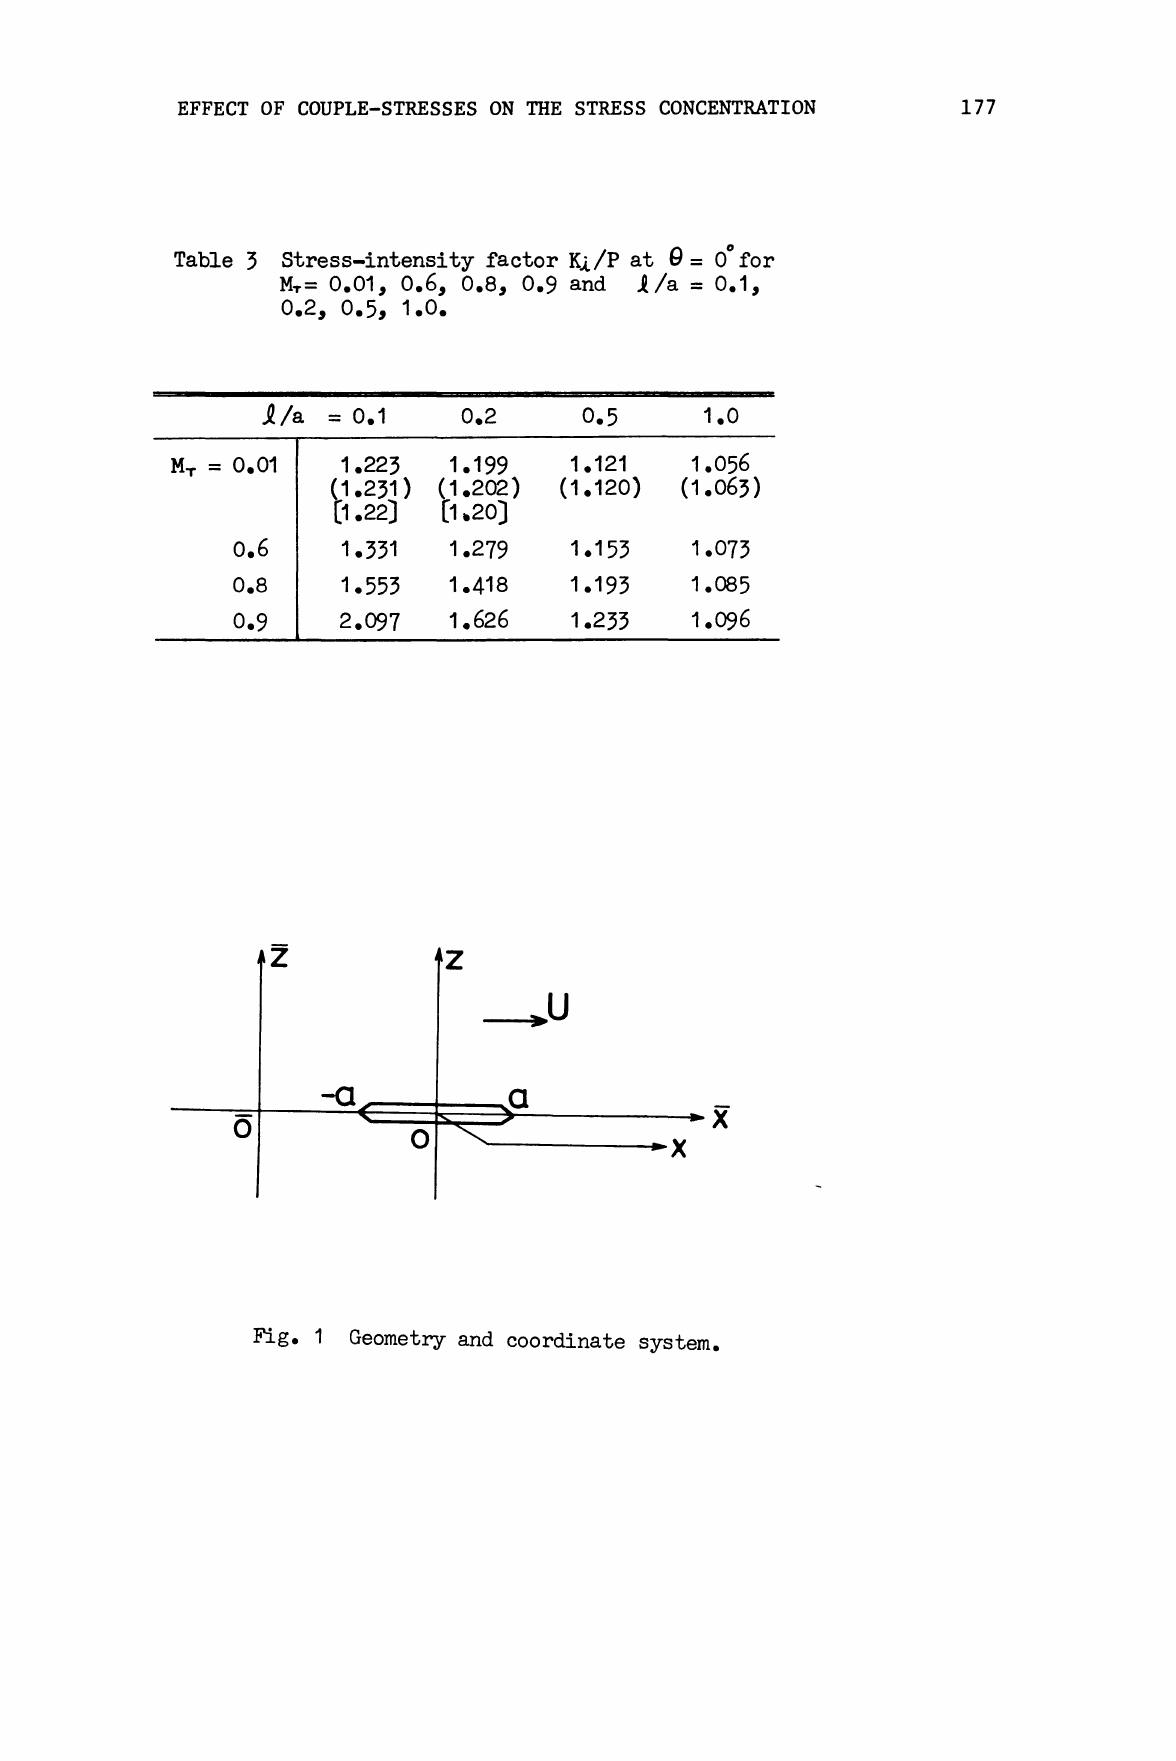
Fig. Geometry and coordinate